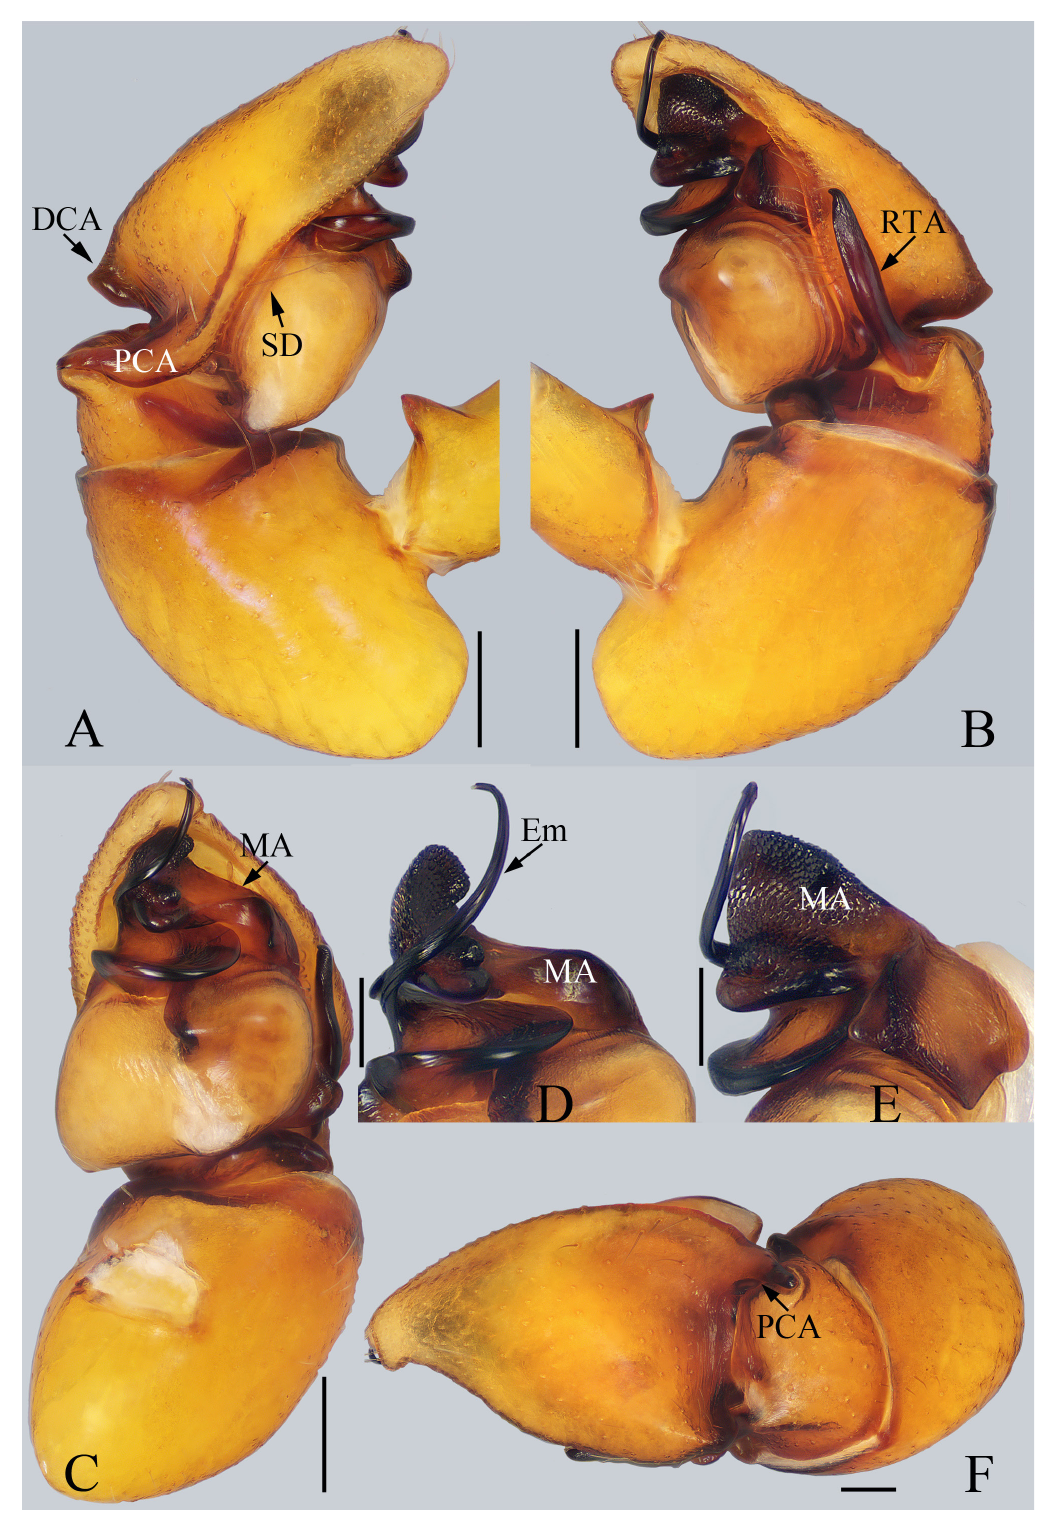
Fig. 9. Male palp of Synagelides longus Song & Chai, 1992 (TRU-Salticid-0020). A . Prolateral view. B . Retrolateral view. C . Ventral view. D . Embolus and median apophysis, ventral view. E . Embolus and median apophysis, retrolateral view. F . Dorsal view. Abbreviations: see Material and methods. Scale bars = 0.1